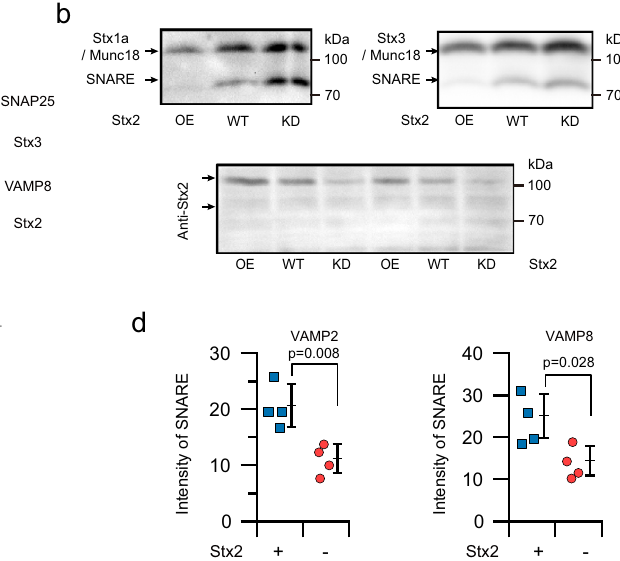
priming factors, Munc18a and Munc13 (in Supplementary Fig. 3b) ( n =3 indepen- dent experiments). c , d Stx2 deletion enhances disassembly of cis -SNARE com- plexes. Native SNARE complexes isolated from INS832/13 by antibody against VAMP2 or VAMP8 were disassembled by recombinant NSF and α -SNAP in the absenceorpresenceofStx2.10mMEDTAwasusedtoinactivateATPhydrolysisby chelating Mg 2+ . SDS-resistant complexes disassemble completely when the sample washeatedto 100°C beforeelectrophoresis. SNAREcomplexes werevisualized by SDS/PAGE and immunoblotting using antibody against SNAP25. Representative blots are shown in c and quanti fi cation in d . Values are mean±s.d. from 4 inde- pendent experiments (two-tailed unpaired Student ’ s t -test). Source data are pro- vided as a Source Data fi